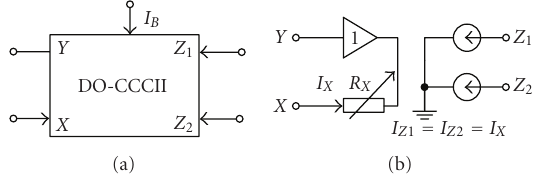
Figure 1: The DO-CCCII (a) symbol (b) equivalent circuit.